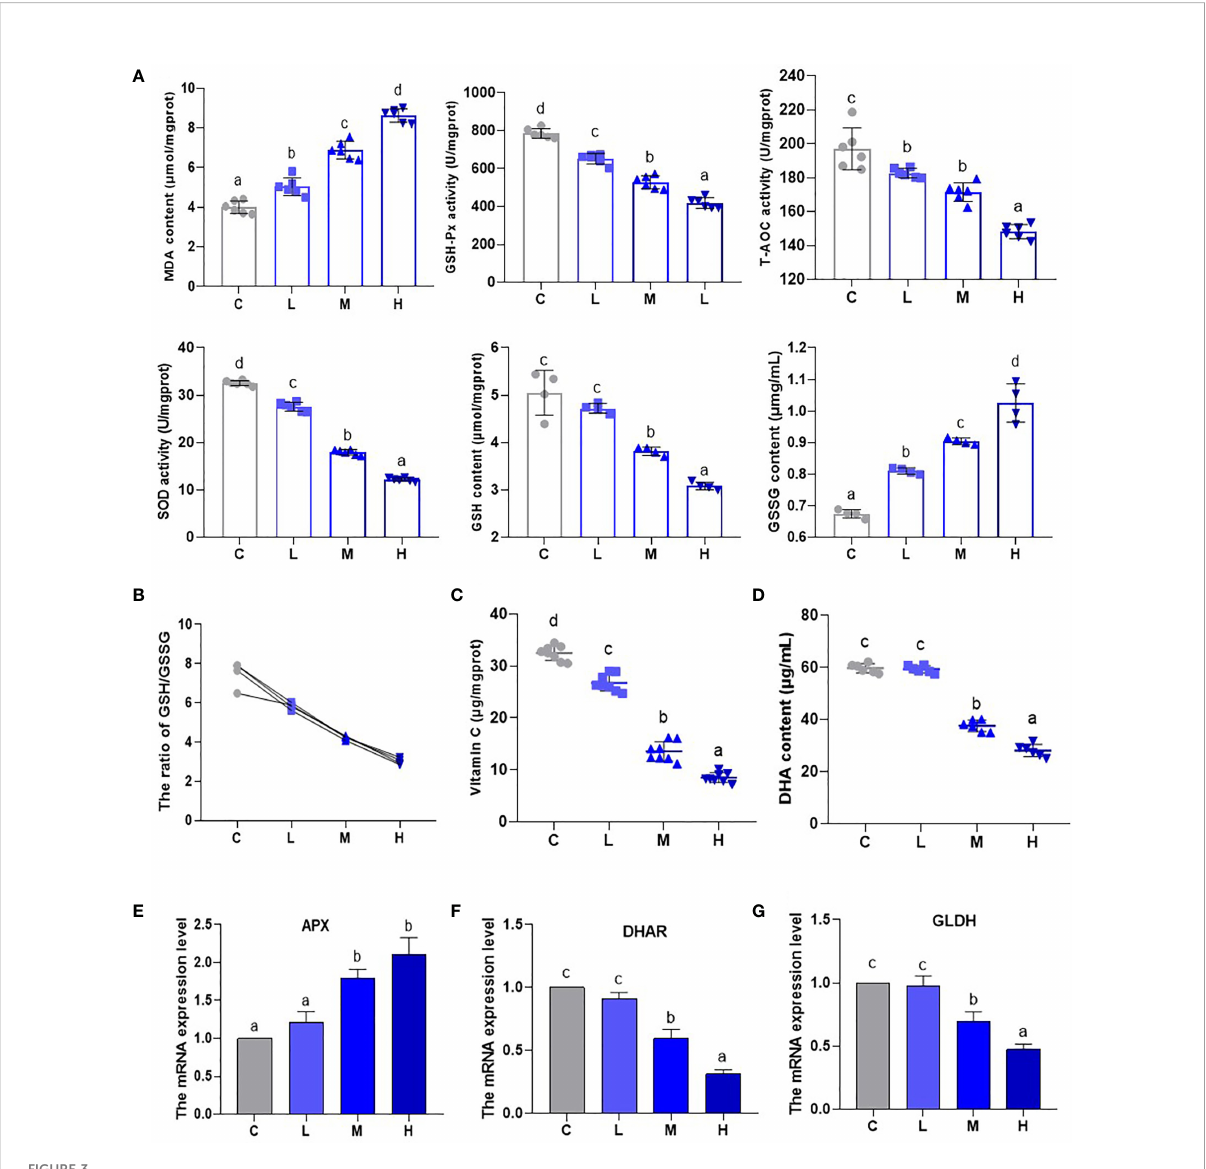
FIGURE 3 The effect of Pb stress on the AsA-GSH cycle of pakchoi. (A) The contents and activities of MDA ( m mol/mgprot), GSH-Px (U/mgprot), T-AOC (U/ mgprot), SOD (U/mgprot) (n=6), GSH ( m mol/mgprot) and GSSG ( m mg/mL) (n=4) in pakchoi. (B) The ratio of GSH/GSSG (n=4). (C) The content of AsA (Vitamin C) ( m g/mgprot) in pakchoi leaves (45 d) (n=8). (D) The content of DHA ( m g/mL) in pakchoi leaves (45 d) (n=8). (E) qRT-PCR analysis of APX mRNA level in pakchoi leaves (45 d) (n=3). (F) qRT-PCR analysis of DHAR mRNA level in pakchoi leaves (45 d) (n=3). (G) qRT-PCR analysis of GLDH mRNA level in pakchoi leaves (45 d) (n=3). The same letter indicates no signi fi cant difference (P > 0.05); completely different letter indicates signi fi cant difference (P <